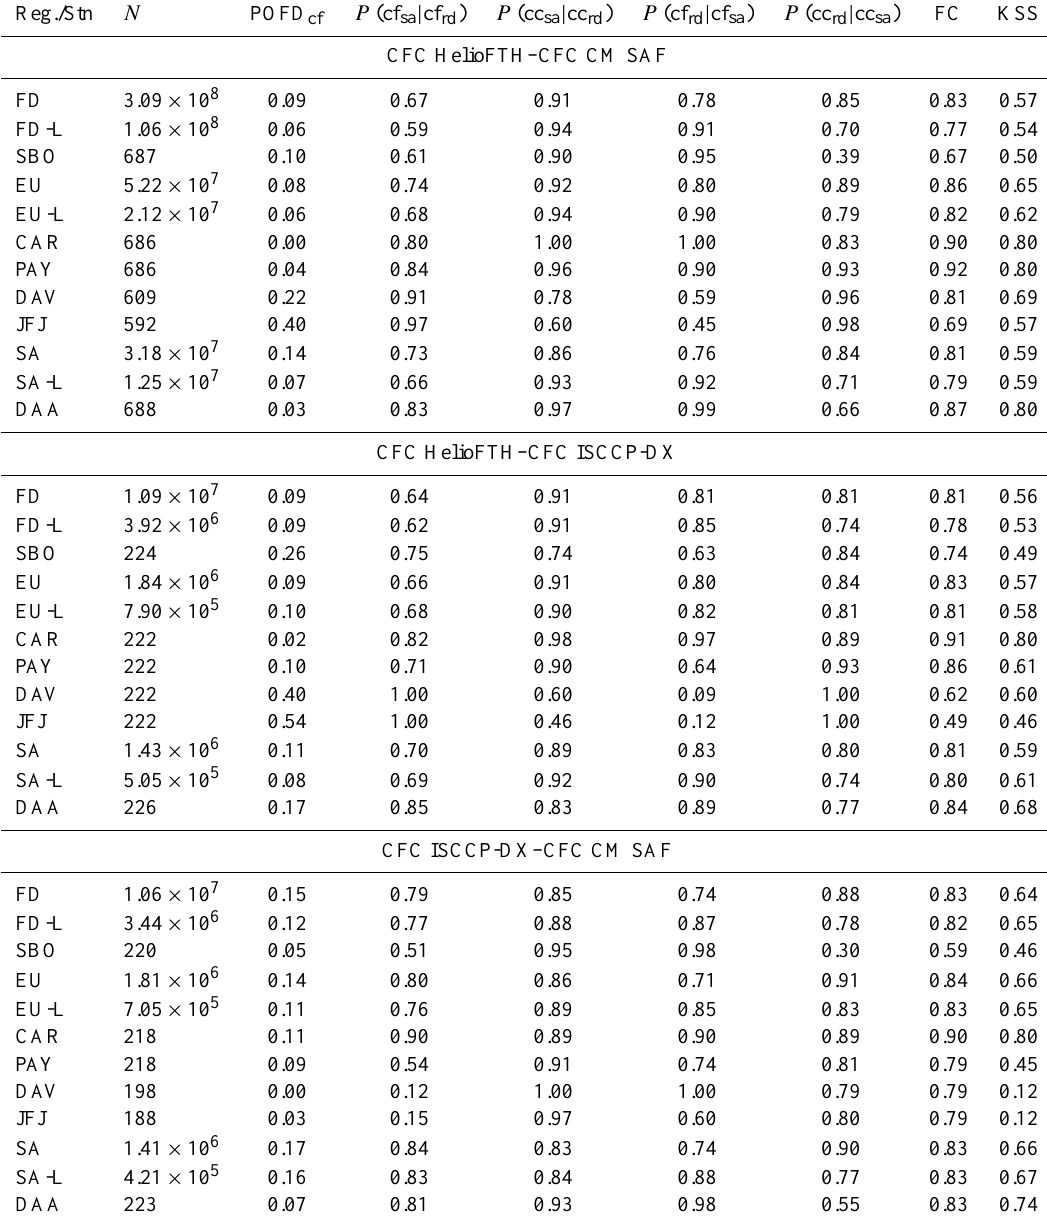
Table 5. Results of the cloud fractional coverage (CFC) product inter-comparison for full disk (FD), Europe (EU), South Africa (SA) and for all sites with synop observations from Table 1 for April 2004. Suffix “L” indicates pixels over land only, N =the number of compared values, FC=fraction correct and KSS=Kuiper Skill